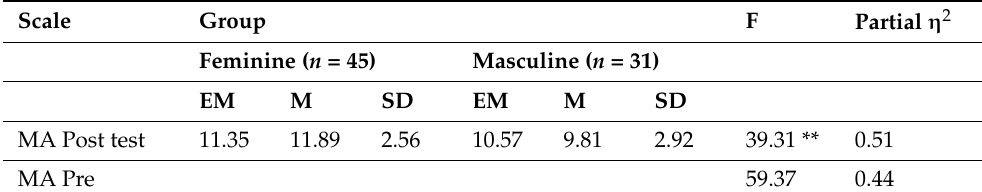
Table 5. The results obtained on the Maturity Scale according to gender (experiment group).